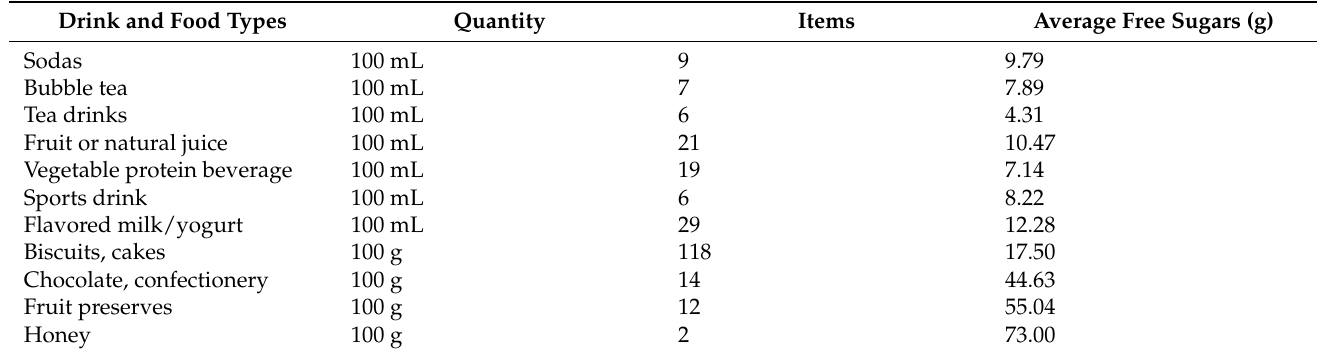
Table A2. The average free sugars content of drink and food